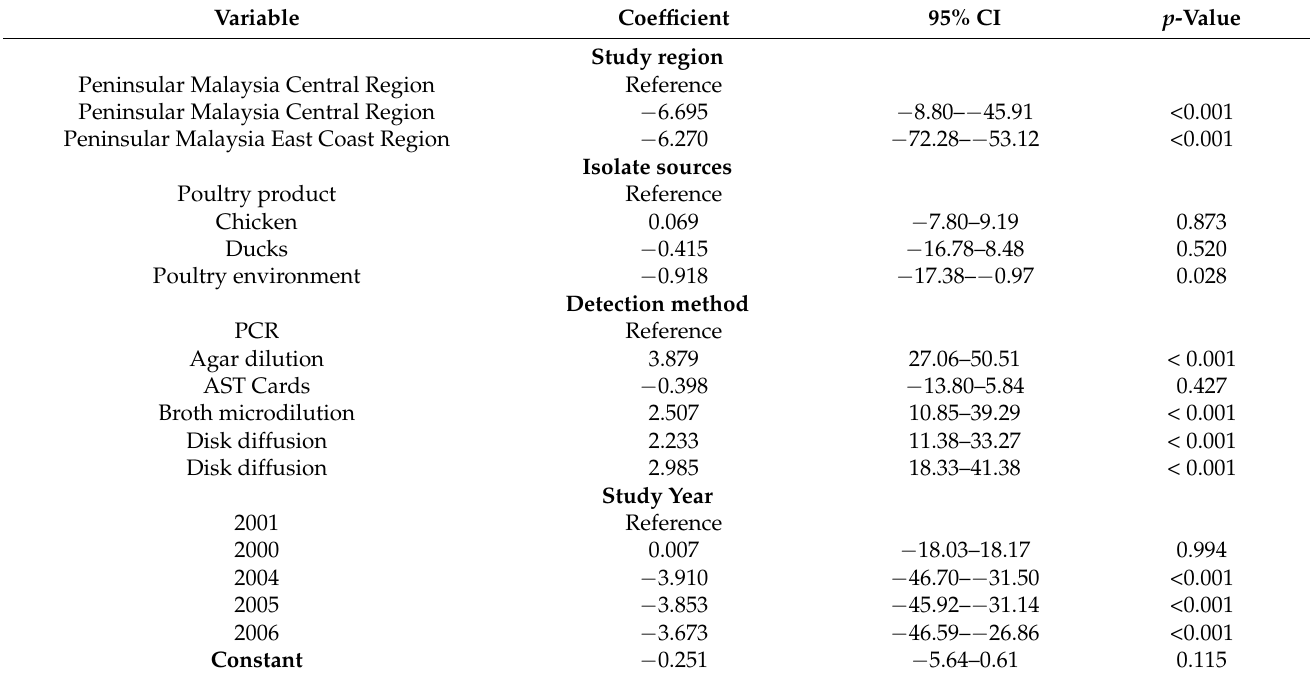
Table 6. Final multivariable meta-regression model of VRE in poultry in Malaysia.